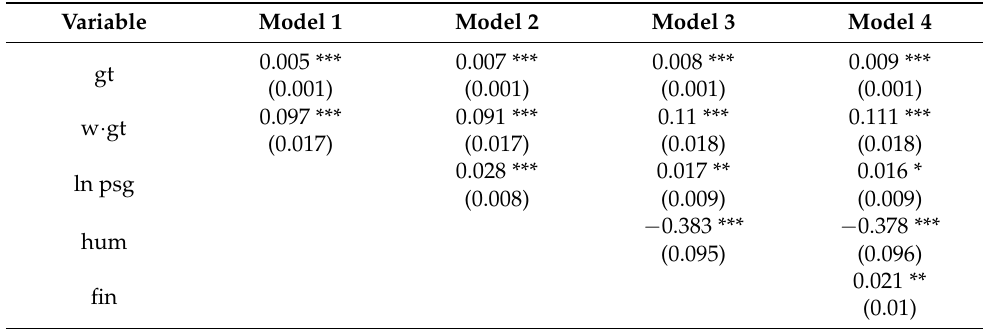
Figure 3. Spatial and temporal distribution of economic growth target in China. ( a ) Spatial distribu- tion of economic growth target in 2011; ( b ) spatial distribution of economic growth target in 2014; ( c ) spatial distribution of economic growth target in 2017. Table 4. Benchmark regression